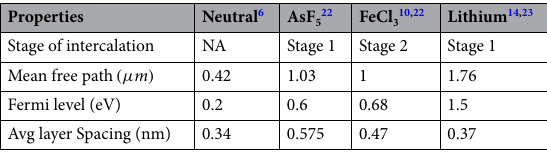
Table 1. Electronic properties of different intercalated MLGNR interconnects.